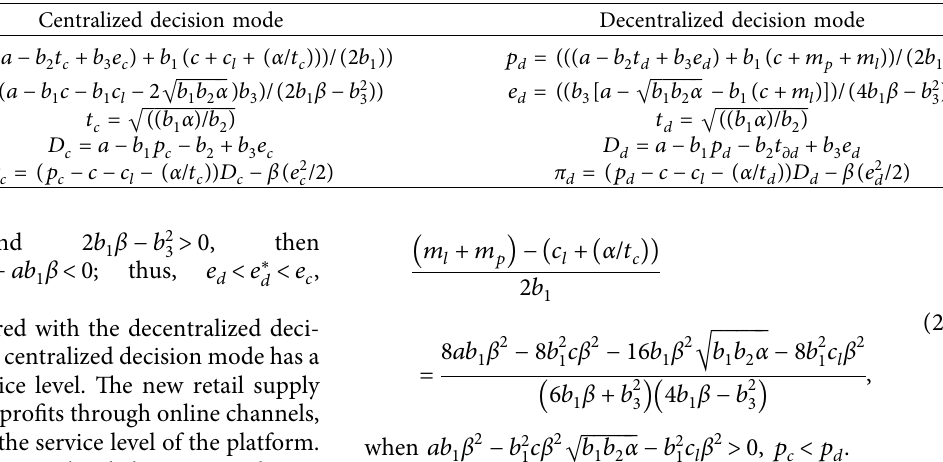
Table 1: Centralized and decentralized decision mode calculation